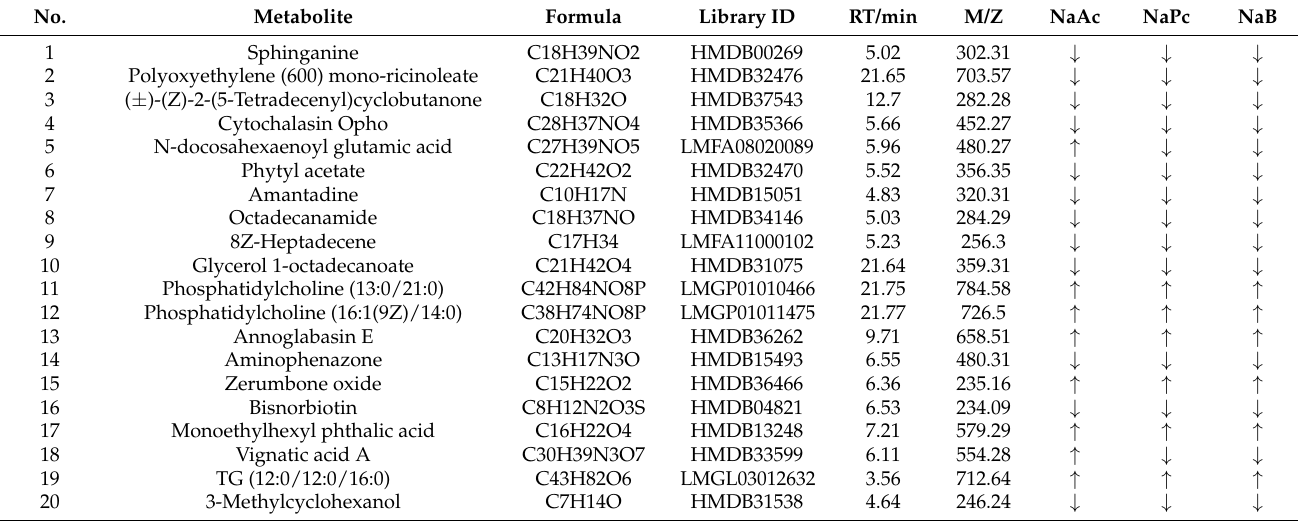
Table 1. Cellular metabolites of THP-1 cells treated with